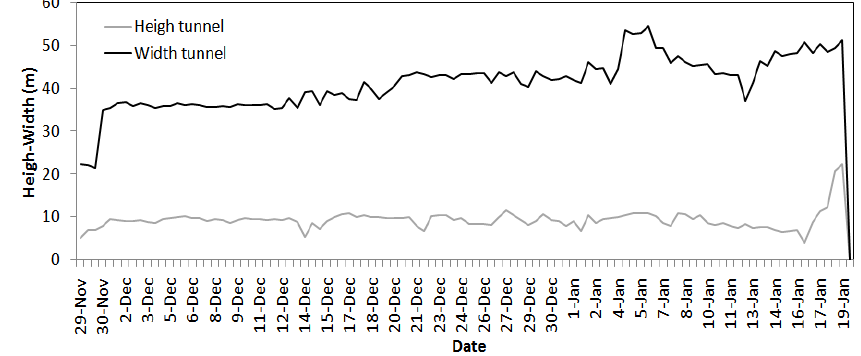
Figure 6. Height and width evolution of the tunnel.